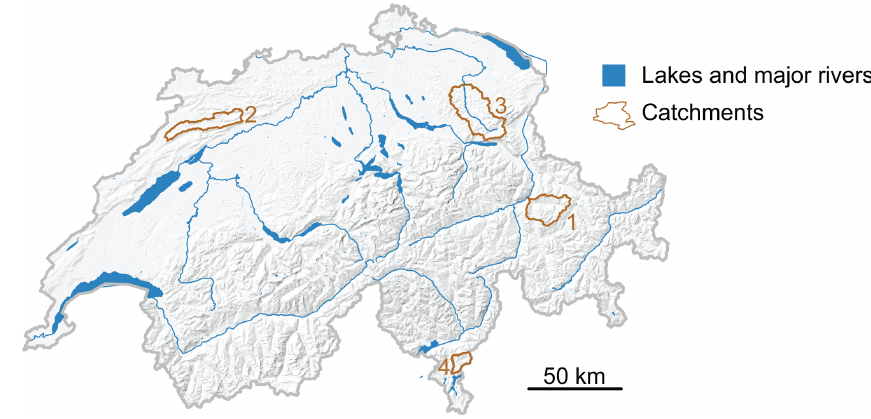
Figure 1. Map showing the four Swiss catchments: (1) Plessur, (2) Birse, (3) Thur, and (4)